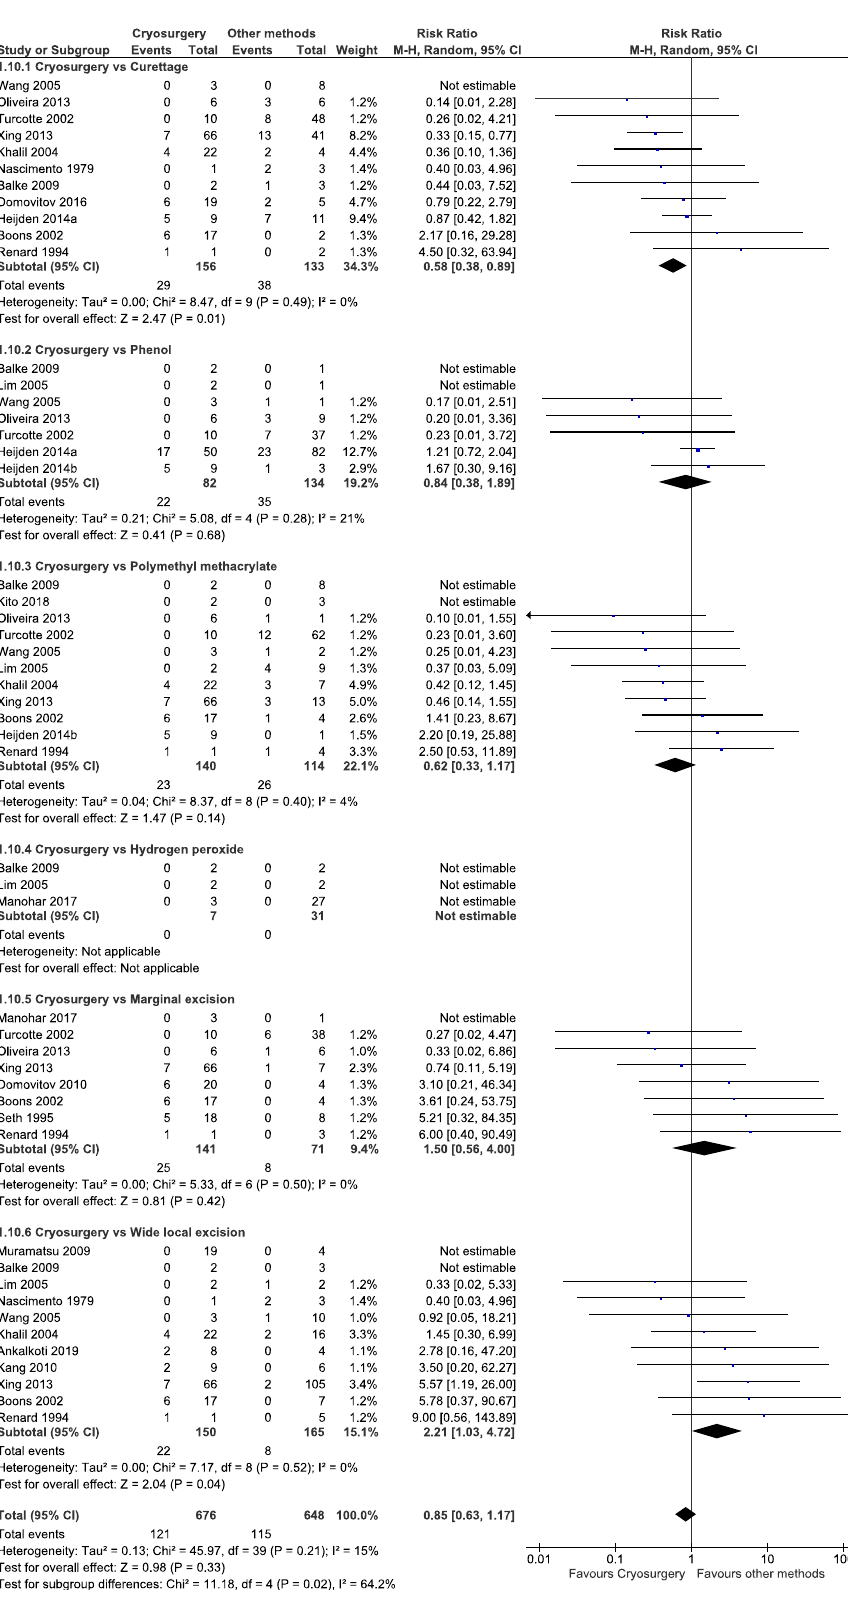
Figure 4. Risk of developing local recurrence followed by cryosurgery vs other methods in giant cell tumours.